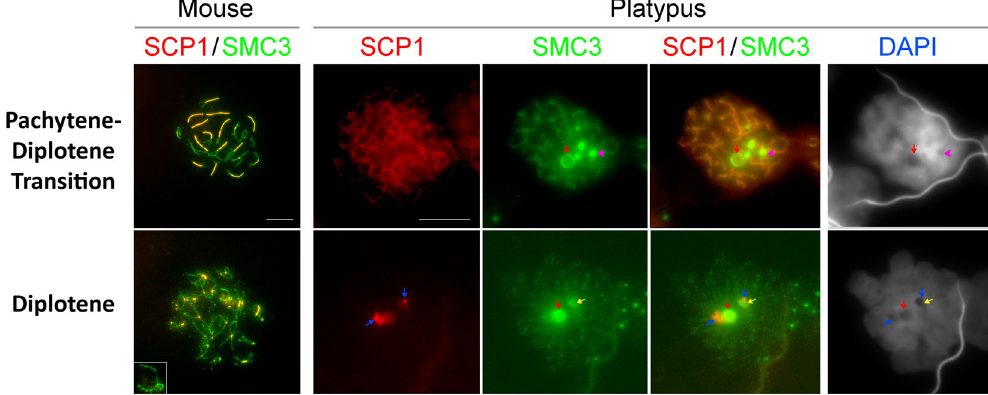
Figure 6. Pachytene-diplotene transition and diplotene in mouse and platypus prophase I cells. In platypus diplotene, four large protein bodies (large pink arrow heads) are observed and the large nucleolus persists (red arrow). In mouse diplotene cells, only the sex chromosomes have SMC3 staining at the axial core, while the staining on autosomes is significantly reduced to foci spread along the axial cores. In platypus there is only weak SMC3 staining scattered on the chromosomes. Also in platypus, there is a larger region that contains SMC3 (red arrow) and a smaller region that contains SMC3 (yellow arrow). Both regions also have a smaller associated region containing SYCP1 (blue arrows). Note that mouse and platypus stages are provided for comparison and may not represent exactly equivalent stages. Scale bar = 10 µ m.